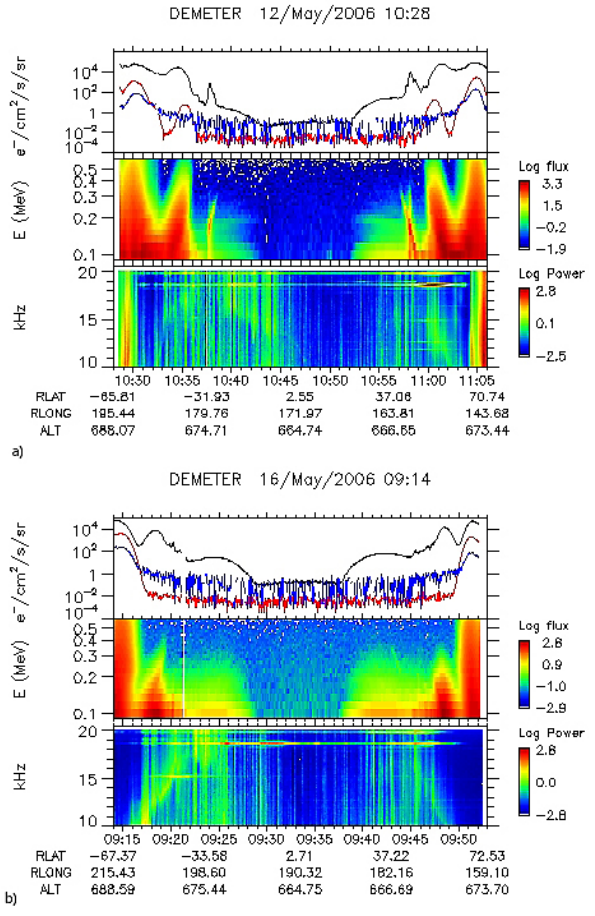
Fig. 4. (a) Electron and wave (see Fig. 1) measurements on 12 May 2006 between 10:26 and 11:06UT. Conjugate electron wisps are de- tected around 10:38 and 10:58UT. (b) Same as (a) for 16 May 2006. This figure must be compared with Figs. 3 and 4 of Sideropoulos et al. (2011).